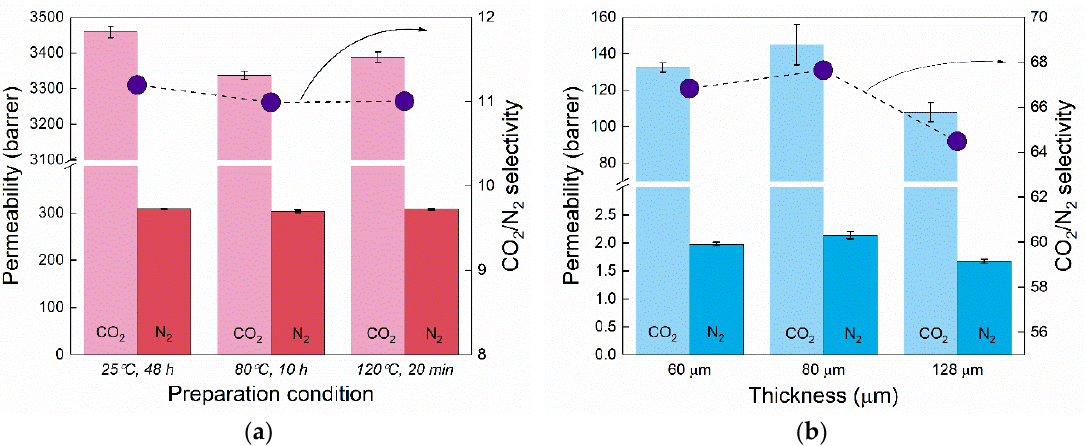
Figure 4. ( a ) Permeability of CO 2 , N 2, and CO 2 /N 2 selectivity in bulk casted PDMS membranes crosslinked in different temperature conditions. ( b ) Permeability of CO 2 , N 2, and CO 2 /N 2 selectivity in bulk Pebax-1657 films with different thicknesses fabricated via solution casting.